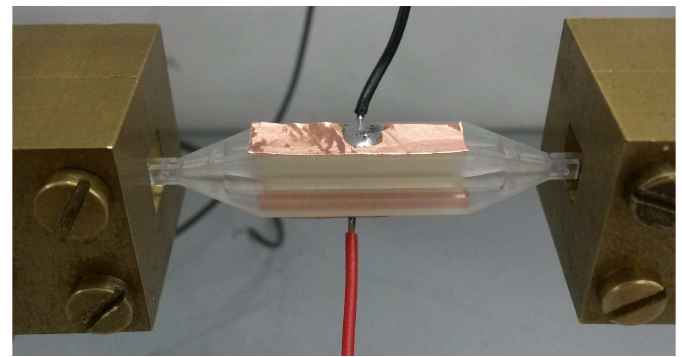
Figure 11. Fabricated SIF LC phase shifter presented in [22].